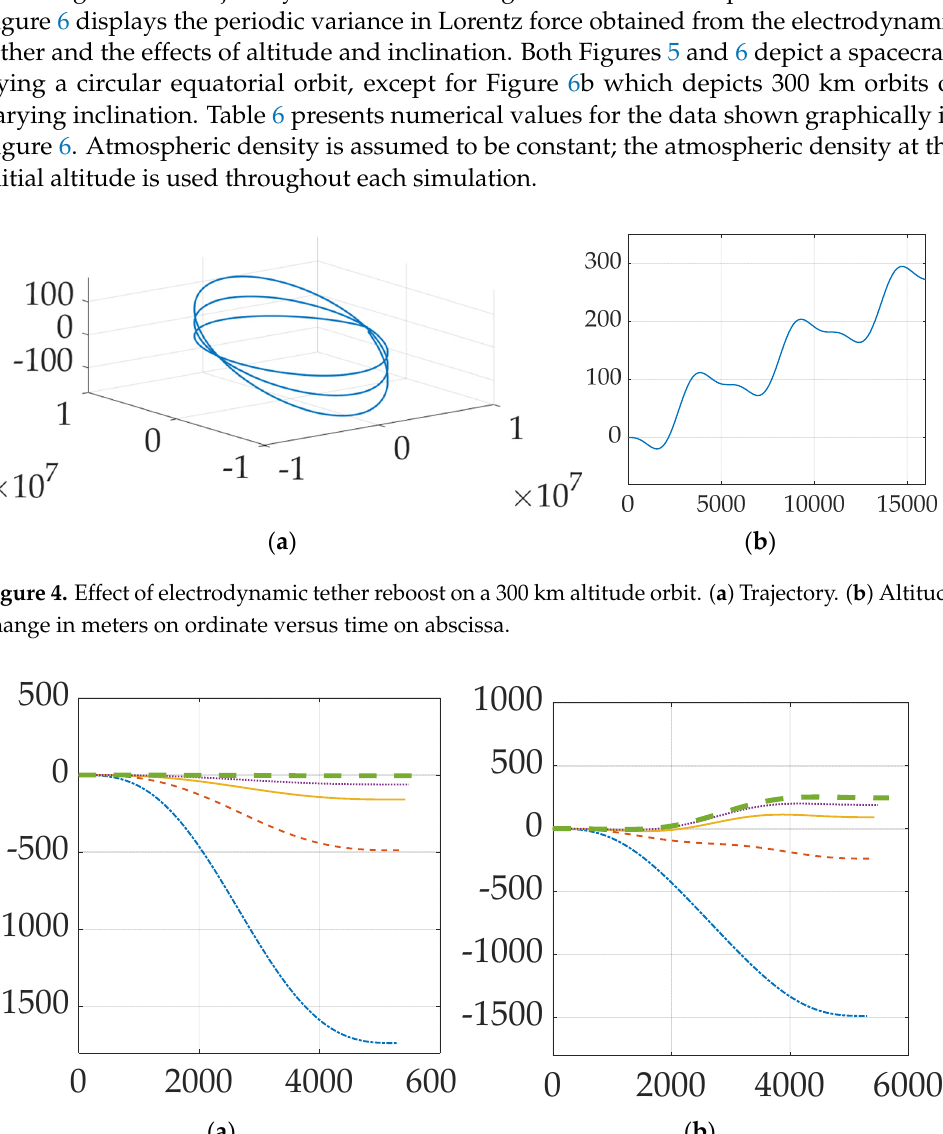
( c ) Figure 6. Lorentz force extracted from electrodynamic tether with time in seconds on the abscissa and ( a ) Altitude (kilo- meters) on the ordinate where 200 km is blue, dash-dotted line; 250 km is red dashed line; 300 km is solid yellow line; 350 km is dotted purple line, and 500 km is green, thick dashed line; ( b ) Inclination (degrees) on the ordinate, respectively where 0 degrees is blue, dash-dotted line; 10 degrees is red dashed line; 30 degrees is solid yellow line; 60 degrees is dotted purple line, and 90 degrees is green, thick dashed line. ( c ) Lateral miss distance (meters) from orbit trajectory due to tether deflection (degrees) over one revolution on the ordinate. Zero degrees is displayed by the dashed blue; 10 degrees is displayed by the red dashed line; 20 degrees is displayed by the solid yellow line. x(cid:3548) and y(cid:3548) coordinates ( × 10 (cid:2875) ) on the horizontal plane with z(cid:3548) coordinates displayed vertically.